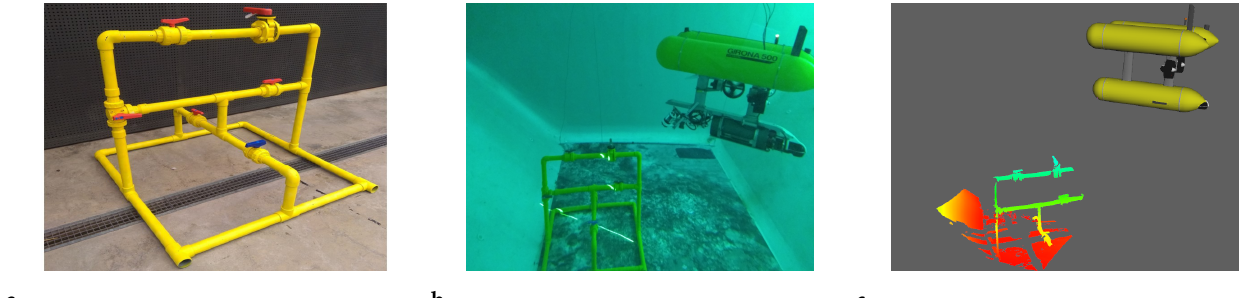
Figure 11. Image of the Girona 500 AUV inspecting the structure. The mapped structure before deployment ( a ), underwater view of the water tank ( b ) and online 3D visualizer with a scan of the structure ( c ).